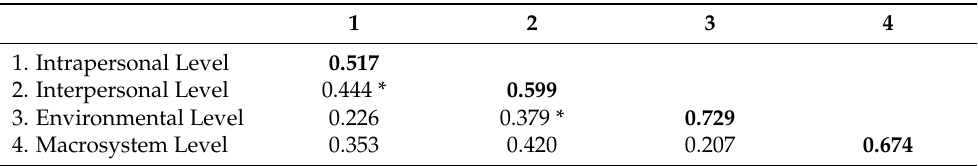
Table 2. Discriminant validity of the scale measuring factors influencing healthy eating